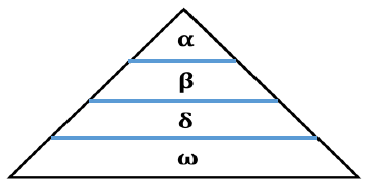
Figure 1. Grey wolf pecking